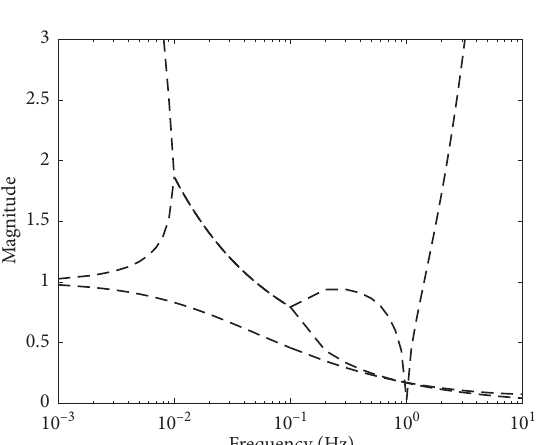
Figure 5: Amplitude radio (by Lee).